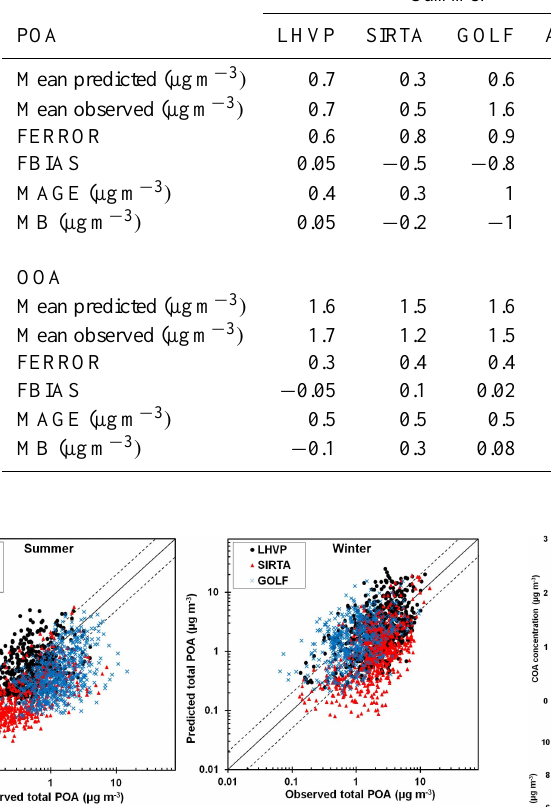
Figure 7. Comparison of predicted vs. observed PM 1 total POA (µgm − 3 ) , including the added COA emissions, from the three mea- surement stations during the MEGAPOLI summer and winter cam- paigns. Each point is an hourly average value. Also shown are the 1:1, 2:1 and 1:2 lines. Observed data represent AMS factor- analysis results. Figure 8. Average diurnal profile of COA concentrations in LHVP and SIRTA during the MEGAPOLI summer and winter campaigns. The shaded vertical bars indicate the 25th and 75th percentiles (gray color represents the predicted and pink the observed